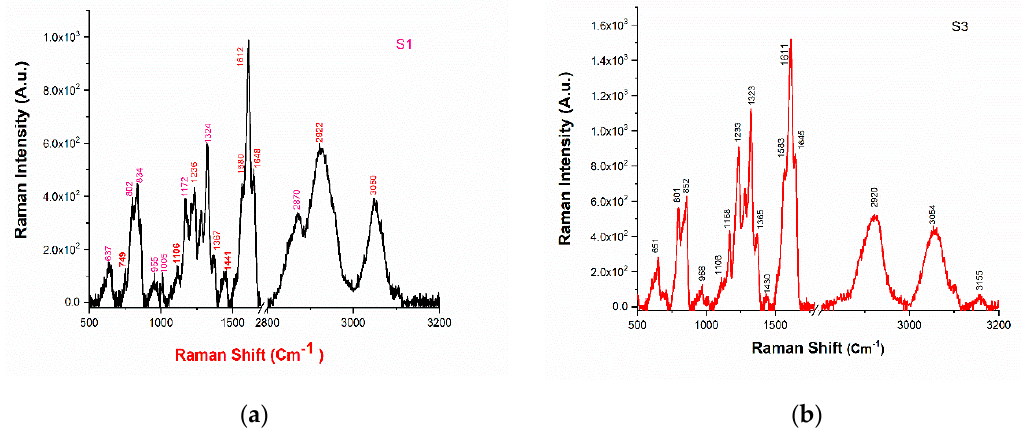
Figure 6. ( a ) The Raman spectrum of sample S1; ( b ) the Raman spectrum of sample